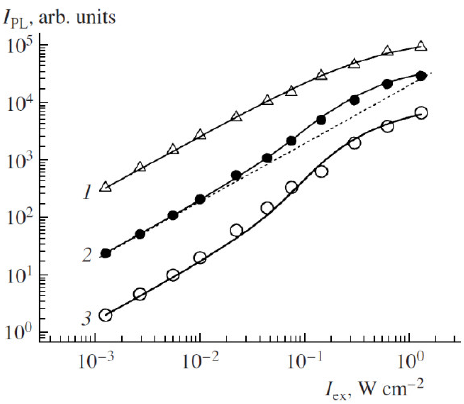
Figure 25. PL intensity of por-Si in vacuum (triangles, h ν PL = 1.47 and 1.5 eV) and with adsorbed O 2 molecules (closed circles, h ν PL = 1.47 eV and open circles, h ν PL = 1.5 eV) vs excitation intensity. Dashed line is a linear law approximation. The datasets are arbitrarily scaled for clarity. Solid lines are the fits by using Equations (16) and (17) with the following parameters: N = 10 19 cm − 3 , σ = 10 − 15 cm 2 , τ ex = 0.8 ms, τ ∆ = 4 ms, β = 5 · 10 − 16 cm 3 / s and n = 0 (curve 1) and oxygen concentrations are taken as n = 10 19 sm − 3 (curve 2), n = 3 · 10 19 cm − 3 (curve 3). Excitation photon energy E exc = 2.41 eV, T = 5 K. (The experimental data are taken from Reference [65]. Reprinted from Reference [79] by permission from Springer Nature Customer Service Centre GmbH. Springer © 2007).